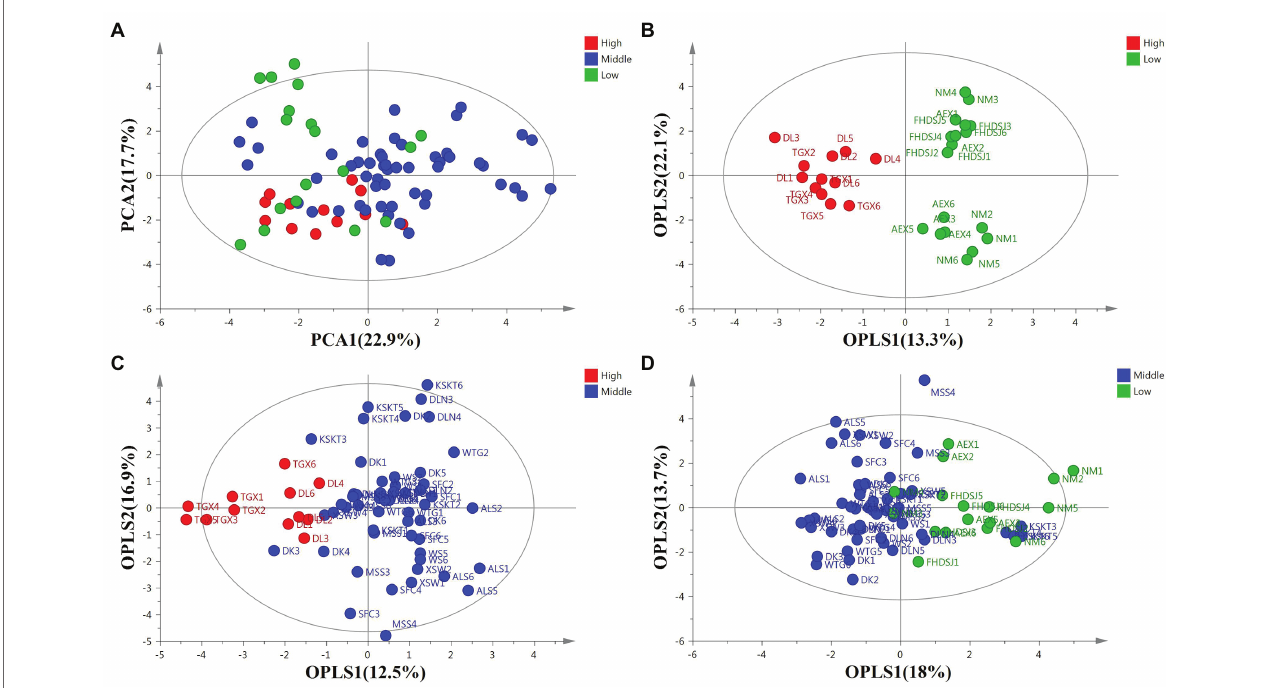
FIGURE 3 | Score plots of flavonoid metabolites in A. squarrosum . (A) Principal component analysis score plot of total samples ( R 2 = 0.559, Q 2 = 0.213). (B) Orthogonal partial least-squares discrimination analysis (OPLS-DA) score plot of high-altitude vs. low-altitude sample (R 2 X = 0.714, R 2 Y = 0.917, Q 2 = 0.777). (C) OPLS-DA score plot of high-altitude vs. middle-altitude sample (R 2 X = 0.422, R 2 Y = 0.586, Q 2 = 0.397). (D) OPLS-DA score plot of middle-altitude vs. low-altitude sample (R 2 X = 0.316, R 2 Y = 0.404, Q 2 = 0.227). Green, blue, and red circles indicate sample sites of low-altitude (~0–1,000 m), middle-altitude (~1,000–2,000 m), and high-altitude (~2,000–4,000 m),